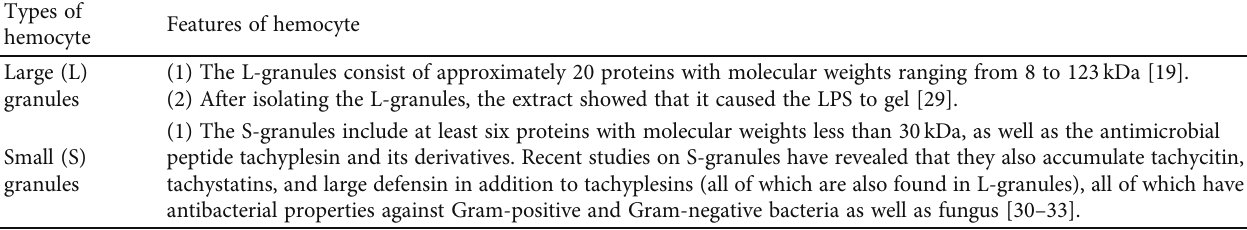
Table 1: Features of large and small granules.